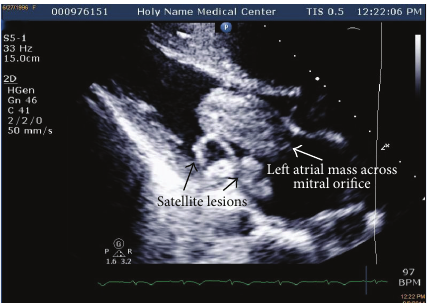
Figure 3: Transthoracic echocardiogram showing left atrial mass with satellite lesions and thickening of the posterior mitral leaflet.